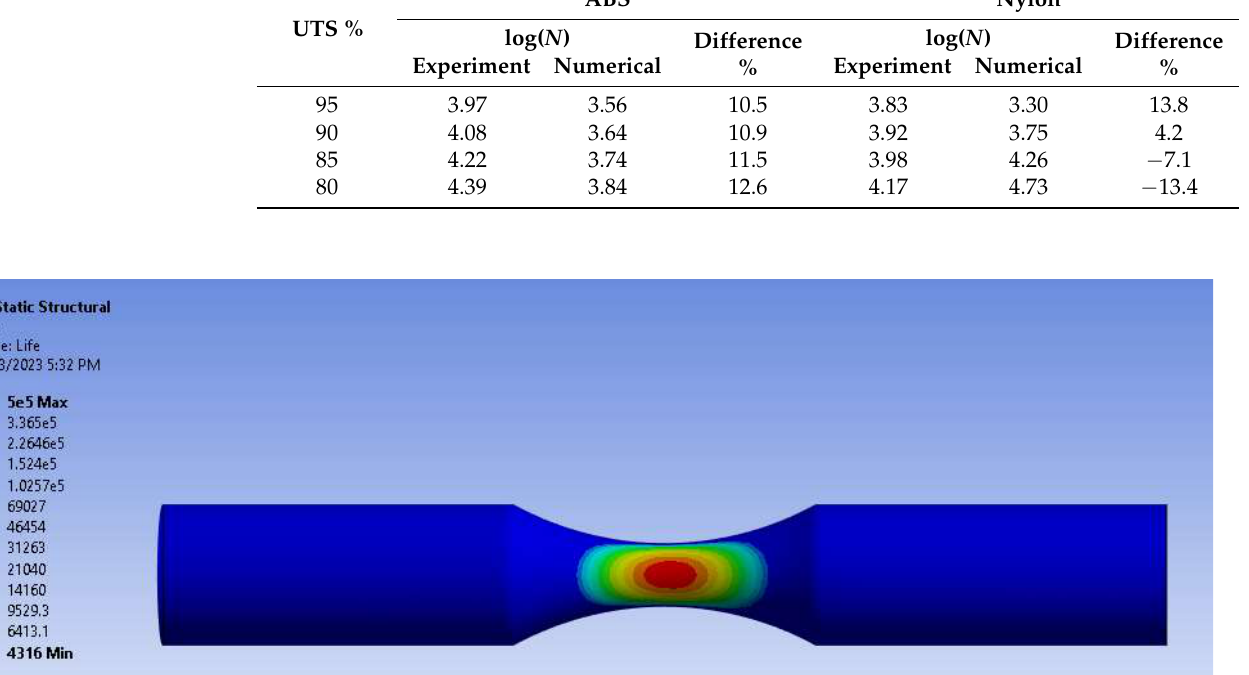
Table 9. Comparison of experimental results and numerically obtained data.